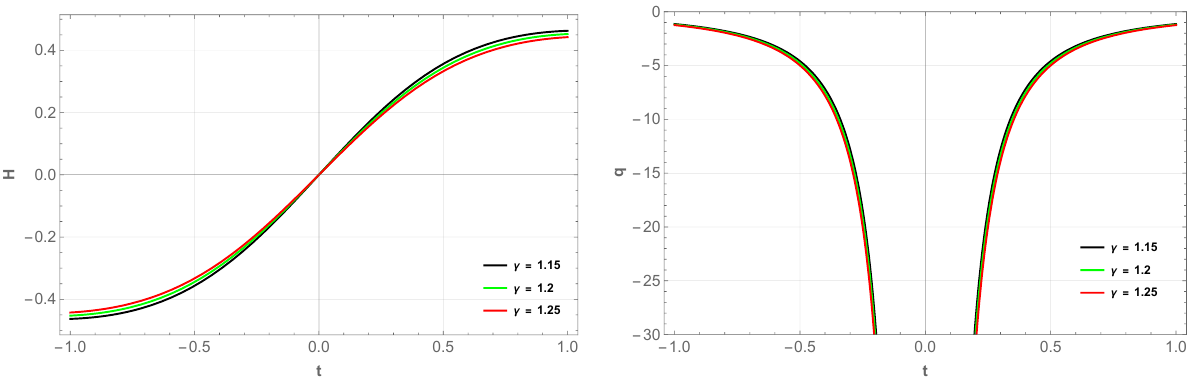
Figure 5. Behavior of the Hubble parameter ( left panel ) and deceleration parameter ( right panel ) versus cosmic time t with λ =